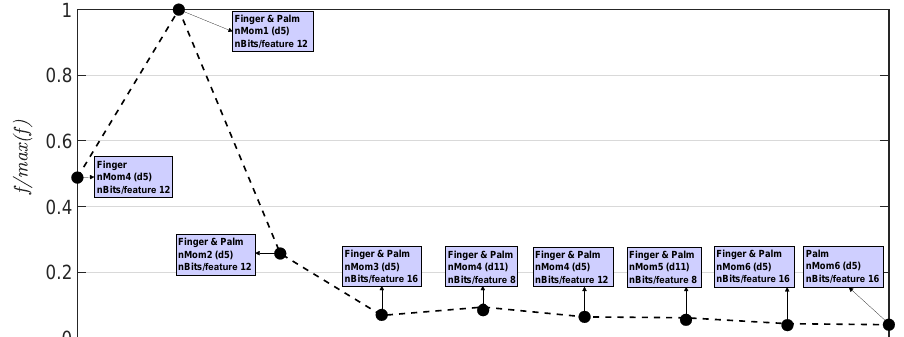
Figure 10. Result of the figure of merit in (2) normalized with respect to the best case. The confusion matrix for the best case Finger&Palm (nMom1-12bits/feature-d5) in